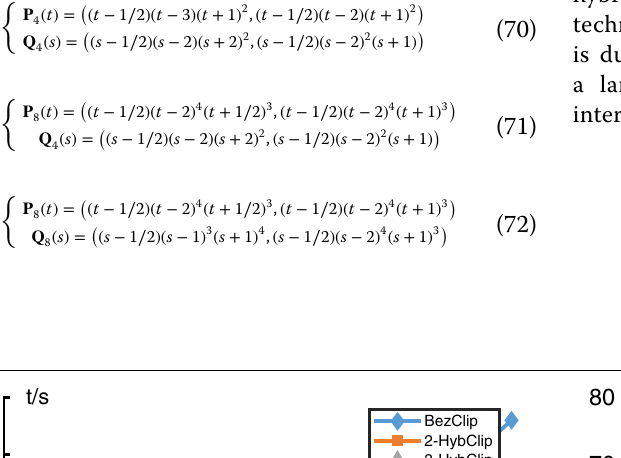
Number of iterations [ N P , N Q ] and computing time t (in microseconds) of accuracy ε . In addition, ( n , m ) are degrees of P , Q , respectively to three pairs of Bézier curves with a transversal intersec- tion. Table 1 reports the number of pairs of iterations and the computing time in microseconds of the desired accu- racy for computing the transversal intersections between the three curve pairs with various degrees. Figure 7 a shows the relationship between the computing time and desired accuracy, and indicates that 3-HybClip based on cubic hybrid curves is significantly improved in compari- son with BezClip, 2HybClip, 2-DegClip, and 3-DegClip.